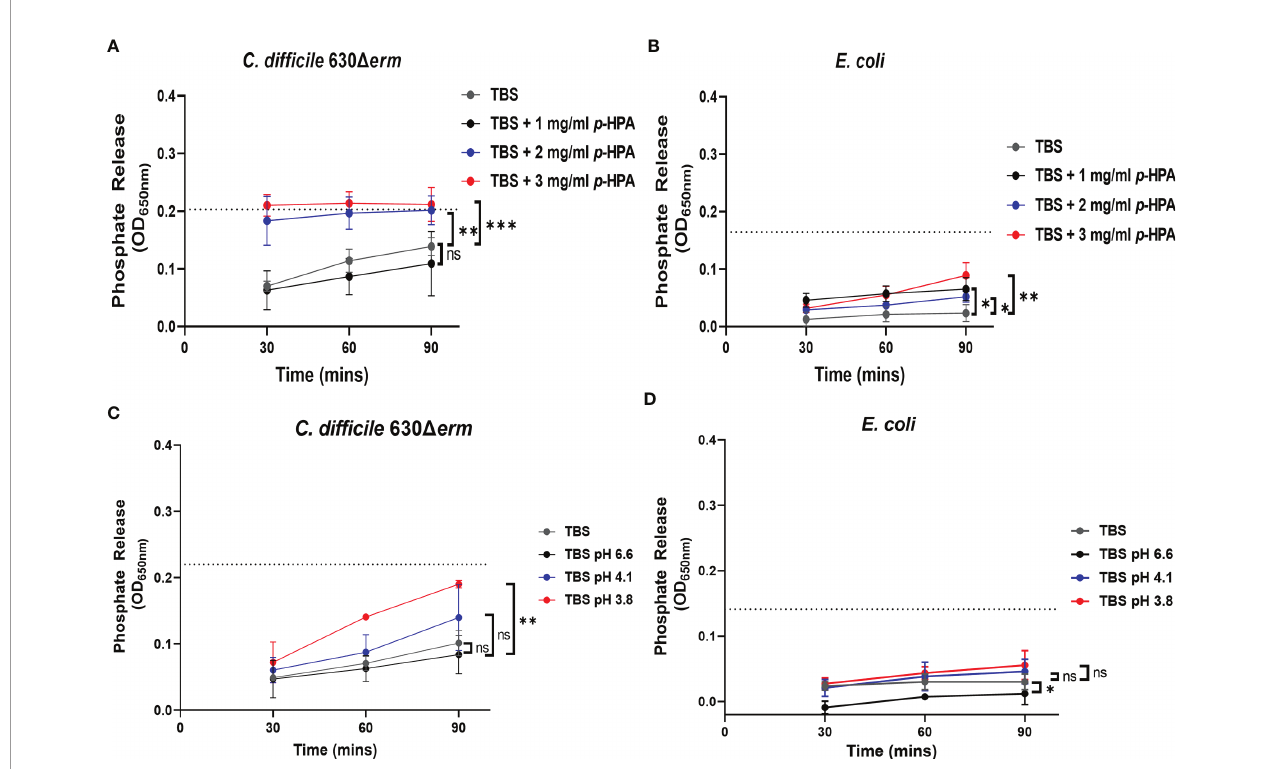
FIGURE 7 | Assessing the effect of p -HPA compared to pH on the membrane integrity of C. dif fi cile compared to E. coli. (A, B) Phosphate release assays were carried out in Tris-buffered saline (TBS) with 0, 1, 2, and 3 mg/ml p -HPA in C. dif fi cile and E. coli , respectively. (C, D) TBS was acidi fi ed to pH 6.6, 4.1, and 3.8, respectively, with the addition of hydrochloric acid, to match the pH of the phosphate release assays undertaken in the presence of p -HPA. Statistical analysis was undertaken using ANOVA to compare phosphate release in p -HPA or acidi fi ed TBS to the TBS control. Data represents the mean and standard deviation of three independent replicates. Signi fi cant differences are indicated: * p < 0.05, ** p < 0.01, *** p < 0.001, ns, non signi fi